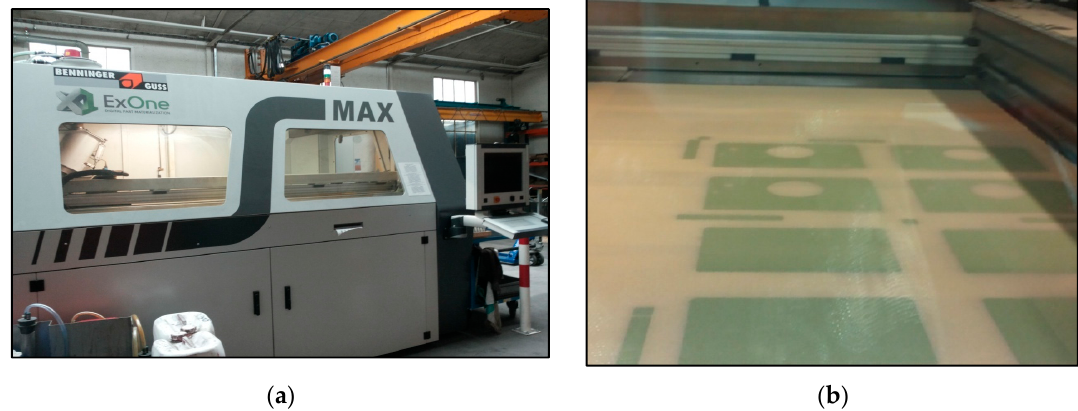
Figure 4. Manufacturing of ceramic molds for the construction of a hydraulic block used in railway installation: ( a ) S-Max ExOne machine for the manufacturing of ceramic parts; ( b ) Image from the manufacturing process of ceramic molds on the S-Max ExOne machine.